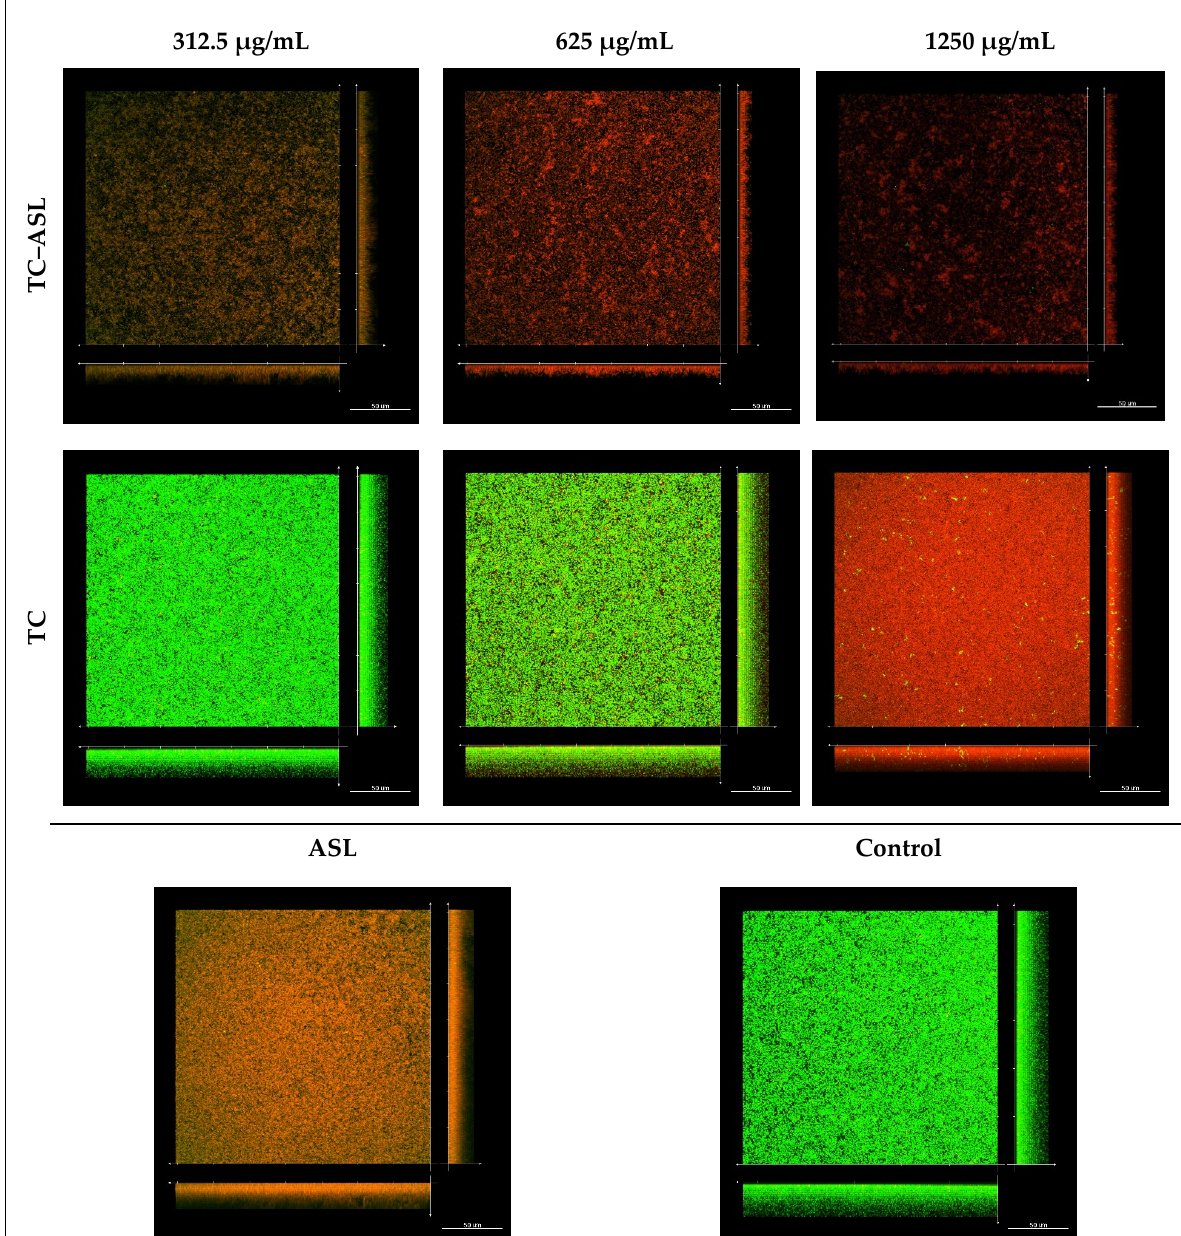
Figure 6. Confocal microscopic images (×60) of E. faecalis biofilms after treatment of TC–ASL, TC, and 1% ASL. The cells with the intact membrane (live) are labeled with the green fluorescent dye (STYO-9), and the cells with damaged membranes (dead) are labeled with red fluorescent dye (PI). The partially damaged cell membranes in which the STYO-9/PI was retained within the cells showed a yellowish-green color [34].